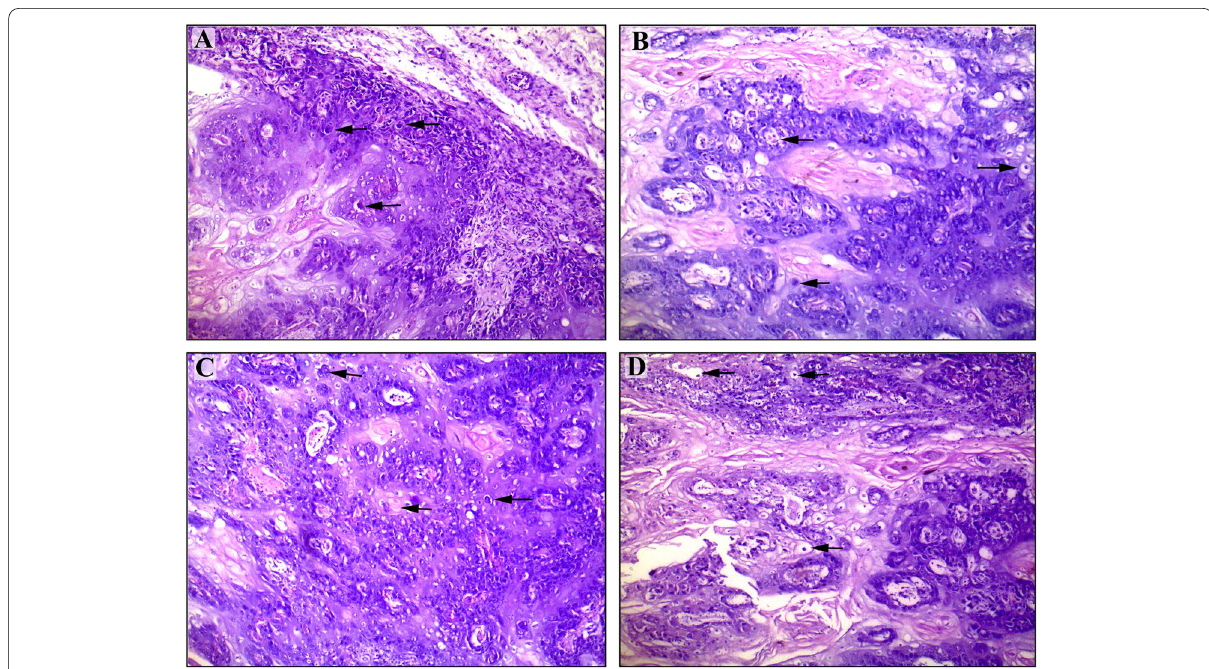
Fig. 3 A photomicrograph showing different fields in poorly differentiated OSCC with evident malignant criteria demonstrating A hyperchromatism, B pleomorphism, C loss of polarity, and D abnormal nuclear cytoplasmic ratio and abnormal mitosis, 24 weeks after exposure to DMBA, group 2A (H&E 100) ×